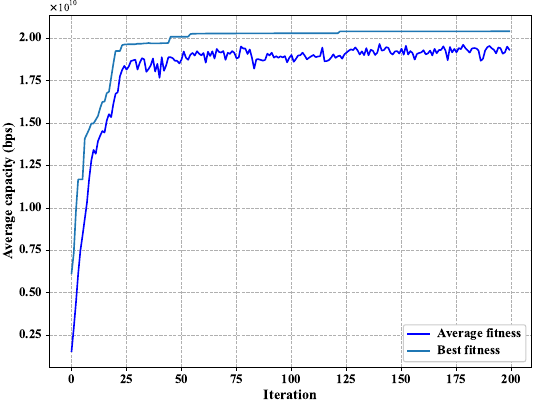
Figure 4. Convergence of the genetic